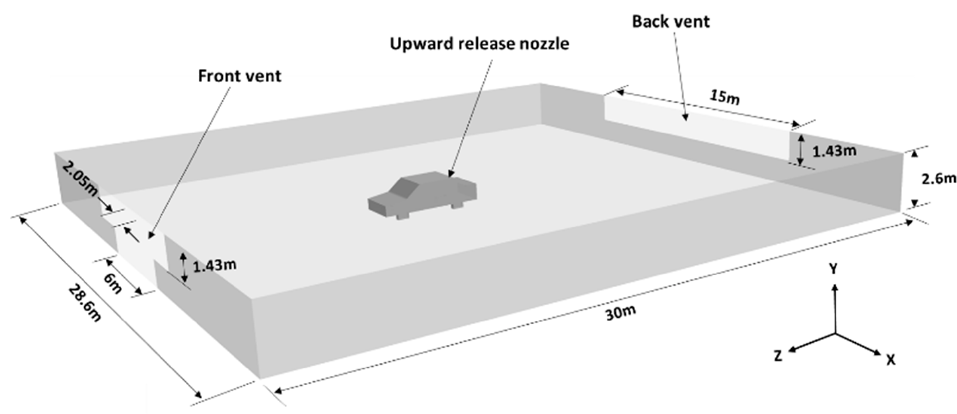
Figure 1. Sketch of the naturally ventilated covered car park with car geometry.